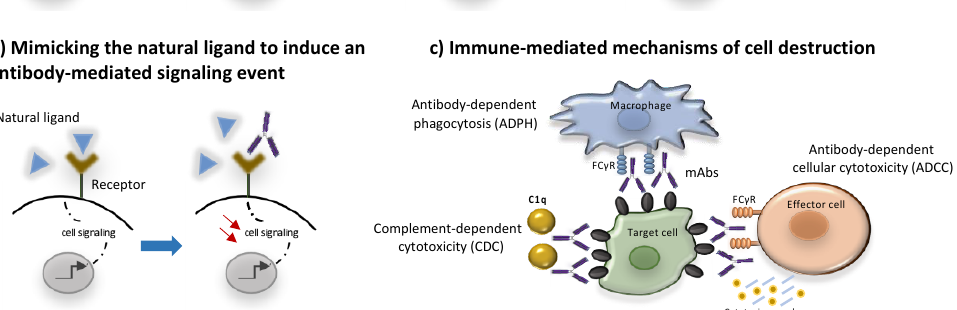
Figure 2. Mechanisms of action of monoclonal antibodies. MAbs may act through direct ( a , b ) or indirect mechanisms ( c ). The direct mechanisms include: ( a ) blocking ligand-receptor interactions through binding to ( i ) a soluble ligand or receptor or ( ii ) to a cell-bound ligand or receptor leading to inhibition of downstream signaling events, ( b ) agonism through binding to a receptor by mimicking its natural ligand leading to the activation of signaling pathways. Indirect mechanisms are immune -mediated as they involve the activation of certain types of immune cells and molecules to kill target cells ( c ) . Most mAbs bear a human IgG1 Fc region that can activate effector cells, such as natural killer (NK) cells to induce antibody-dependent immune cell cytotoxicity (ADCC), or macrophage inducing antibody-dependent phagocytosis (ADPH), through the interaction with their FC γ receptors. Moreover, the Fc region of mAbs can activate the complement leading to complement-dependent cytotoxicity